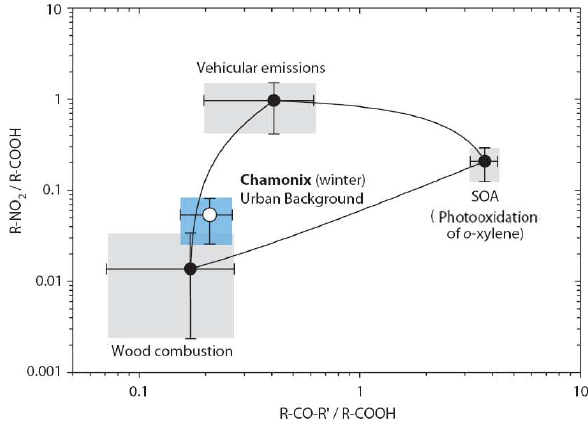
Fig. 3. Average R-NO 2 /R-COOH and R-CO-R 0 /R-COOH ratios (logarithmic scales) obtained for the 3 aerosol sources (black cir- Figure 3. Average R-NO 2 / R-COOH and R-CO-R’ / R-COOH ratios (logarithmic scales) cles) and for the Chamonix urban background aerosol (white circle). obtained for the 3 aerosol sources (black circles) and for the Chamonix urban background The 3 points corresponding to the aerosol sources are connected by aerosol (white circle). The 3 points corresponding to the aerosol sources are connected by solid curves. Error bars represent the standard deviations calcu- solid curves. Error bars represent the standard deviations calculated for each sample series, n lated for each sample series, n = 6 for wood combustion, n = 4 for = 6 for wood combustion, n = 4 for road traffic, n = 4 for o -xylene photooxidation road traffic, n = 4 for o -xylene photooxidation (materialised as grey (materialised as grey boxes for the aerosol sources), and n = 11 for the Chamonix aerosol boxes for the aerosol sources), and n = 11 for the Chamonix aerosol (materialised as blue box). (materialised as blue